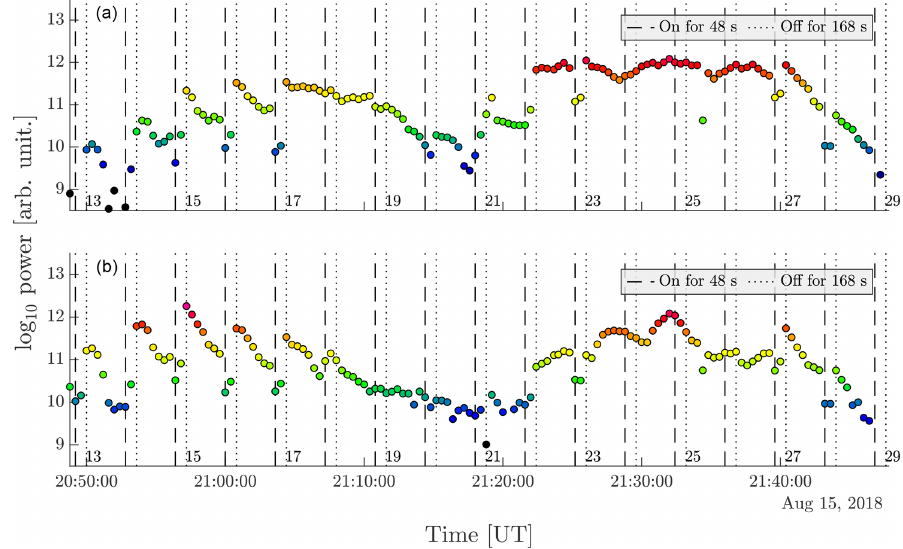
Figure 10. Backscattered power at altitude 87.4 km (b) and 87.8 km (a) and heating intervals observed during the night of 15/16 August 2018 in area 2. The color of the dots follows the color scale of Fig.